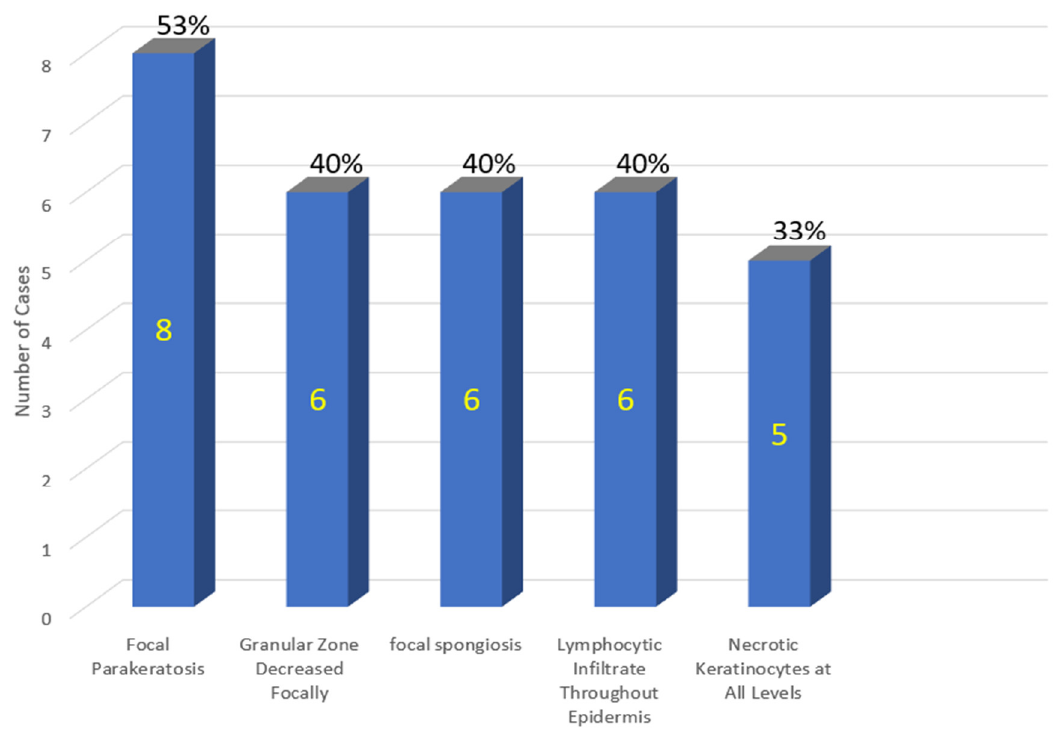
Figure 12. COVID-19 vaccine-induced lichenoid eruptions—case series of 15 patients. Shown on the x-axis are atypical features of the epidermis.